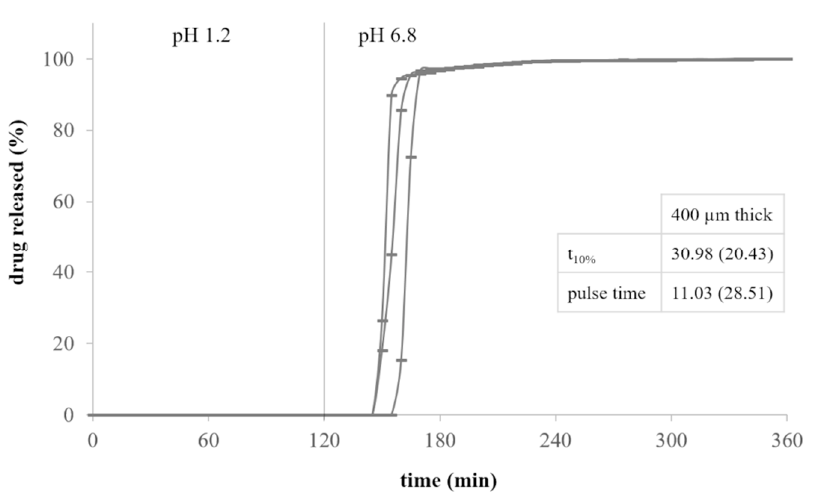
Figure 4. Release profiles of 400 µ m thick EDR-based shells (average release parameters and relevant CV, in brackets, are listed in boxes).